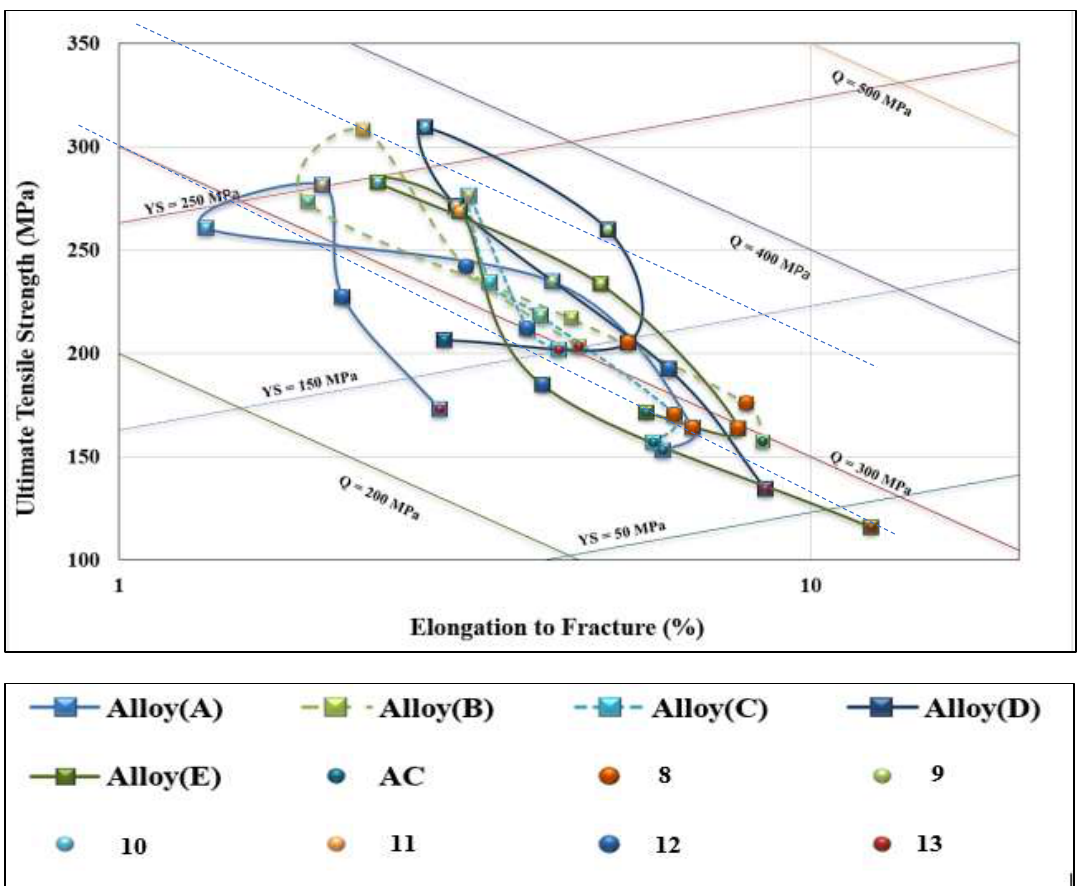
Figure 14. Quality chart showing the relationship between UTS and %El for the five alloys investi- gated in the as-cast and six heat treatment conditions with SHT for 8 h.